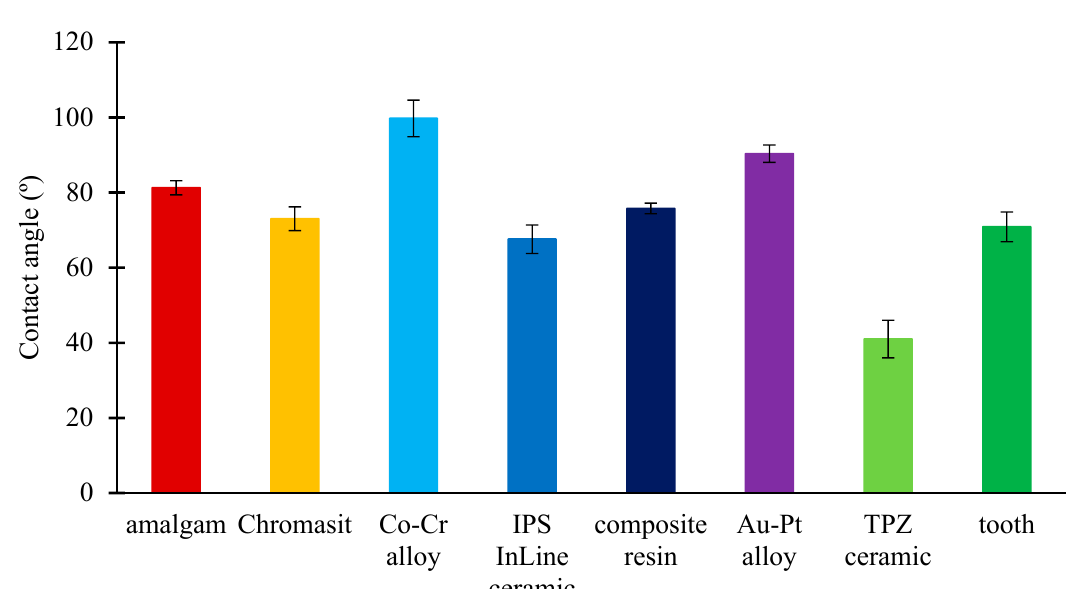
Figure 2. Contact angles of water droplet on dental materials: amalgam, Chromasit, Co-Cr alloy, IPS InLine ceramic, resin-based composite, Au-Pt alloy, TPZ ceramic, and tooth.